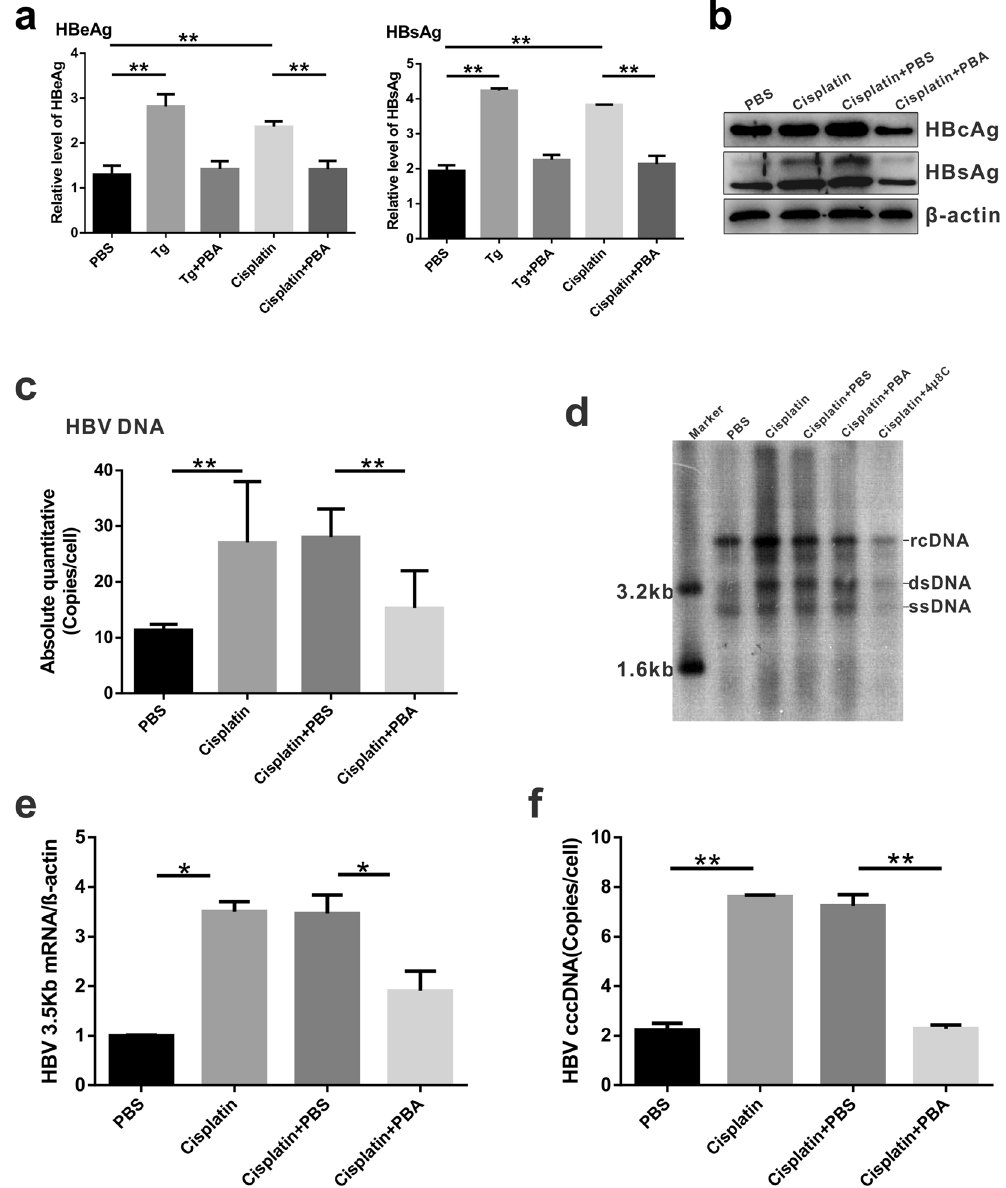
Figure 6. ER stress is required for cisplatin-induced HBV transcription. ( a ) HepAD38 cells were treated with cisplatin, thapsigargin, cisplatin combined with PBA or thapsigargin combined with PBA, respectively. The levels of HBsAg and HBeAg in the culture medium were measured by ELISA. ( b to c ) The expression of intracellular HBcAg and HBsAg ( b ), and HBV DNA ( c ) was determined by western blotting and quantitative PCR, respectively. ( d ) Southern blot analysis of intracellular HBV DNA. The cropped blots are used in the figure and full length blots are presented in Supplementary Fig. S10. ( e to f ) The levels of intracellular HBV 3.5 kb mRNA ( e ) and cccDNA ( f ) were analyzed by quantitative PCR. Data are shown as mean ± SD (independent experiments, n = 3); * p < 0.05, ** p <